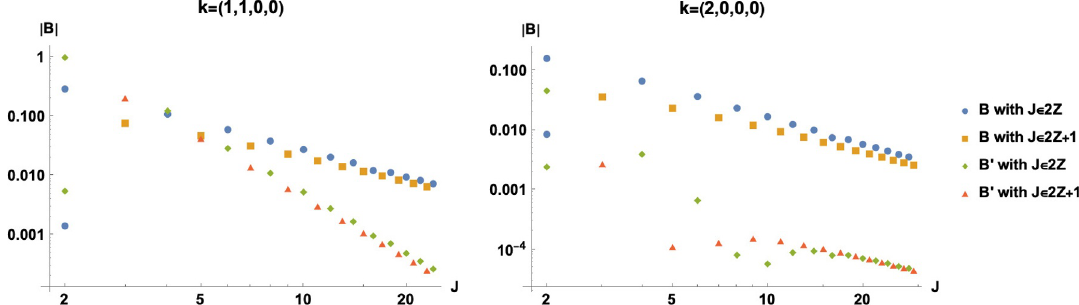
and derivative B 0 func- k ;1 | 34 k ;1 | 34